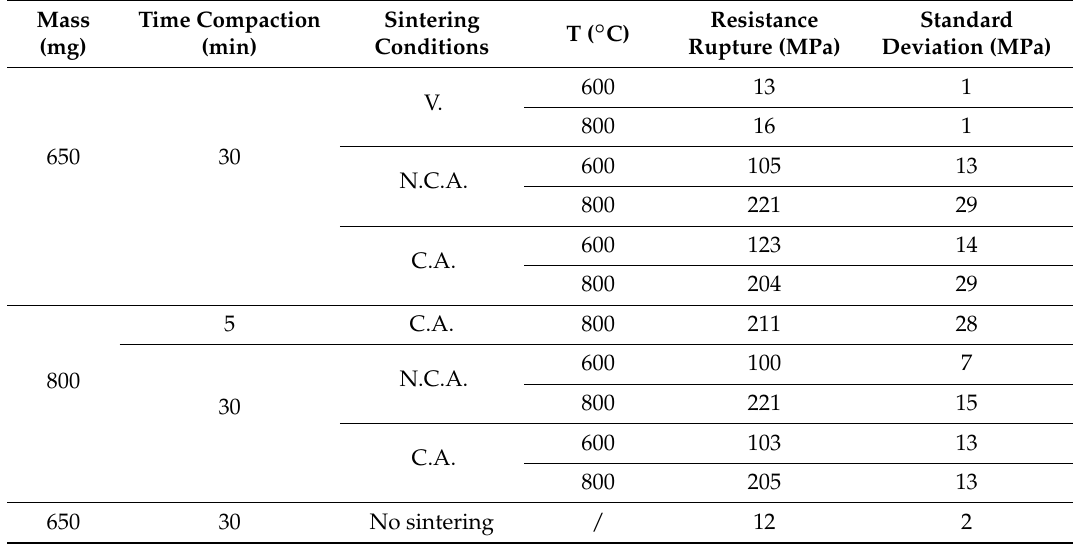
Figure 9. comparison of maximum stress of various sintered target. Figure 9. Comparison of maximum stress of various sintered target. Table 7. Mechanical resistance for different masses and thicknesses of the pellets. Table 7. Mechanical resistance for different masses and thicknesses of the